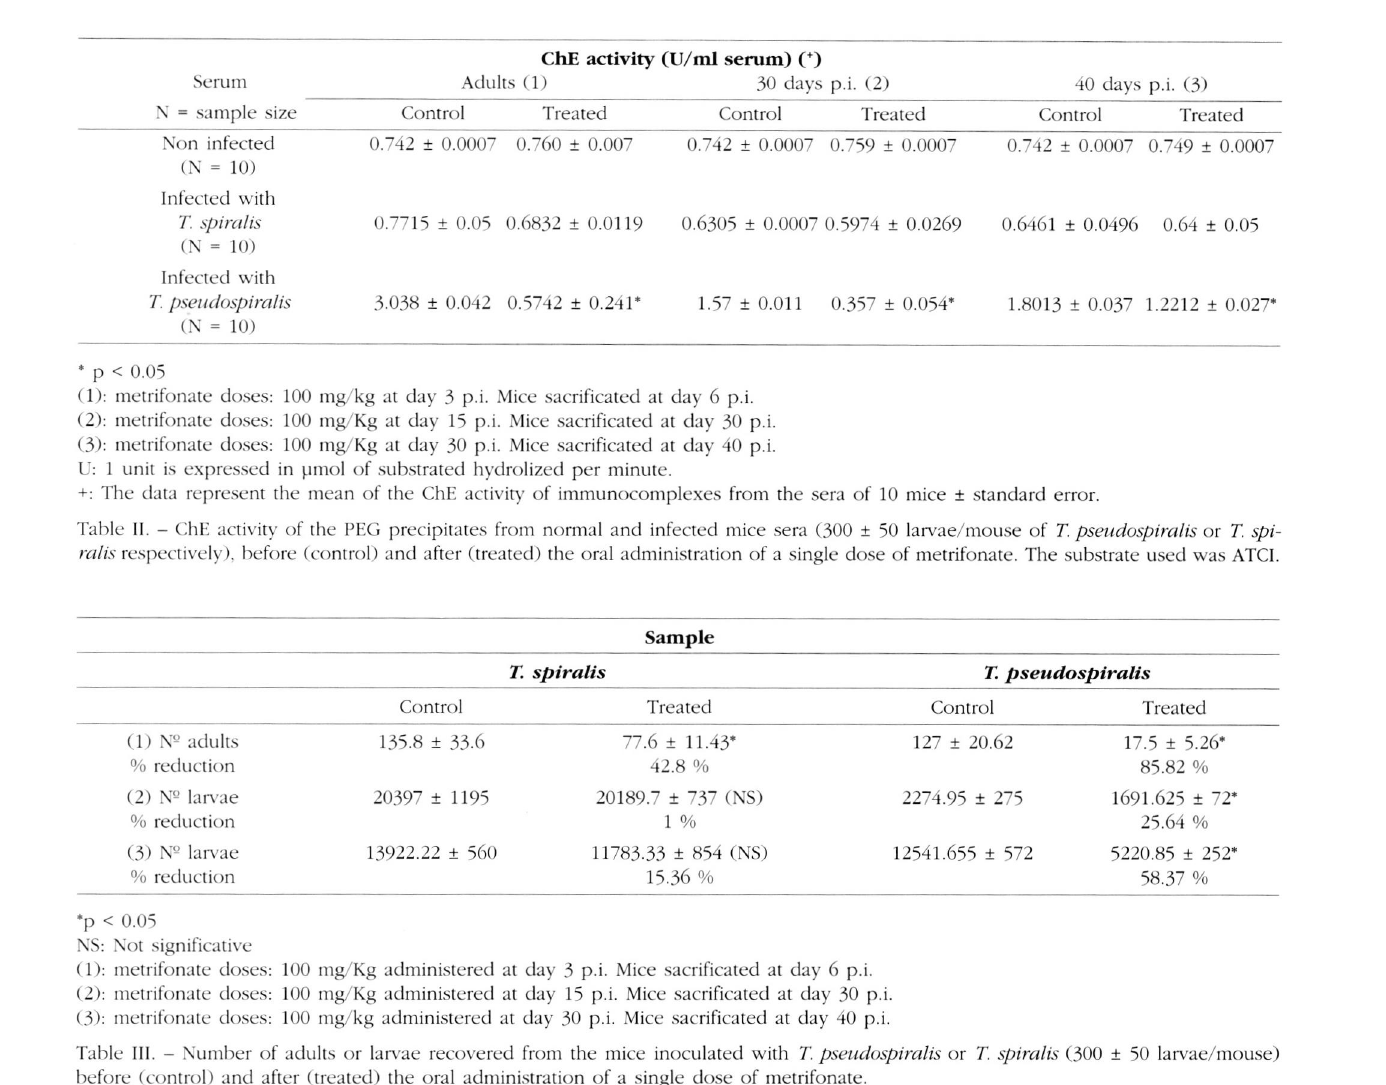
Table III. - Number of adults or larvae recovered from the mice inoculated with T. pseudospiralis or T. spiralis (300 ± 50 larvae/mouse) before (control) and after (treated) the oral administration of a single dose of metrifonate.